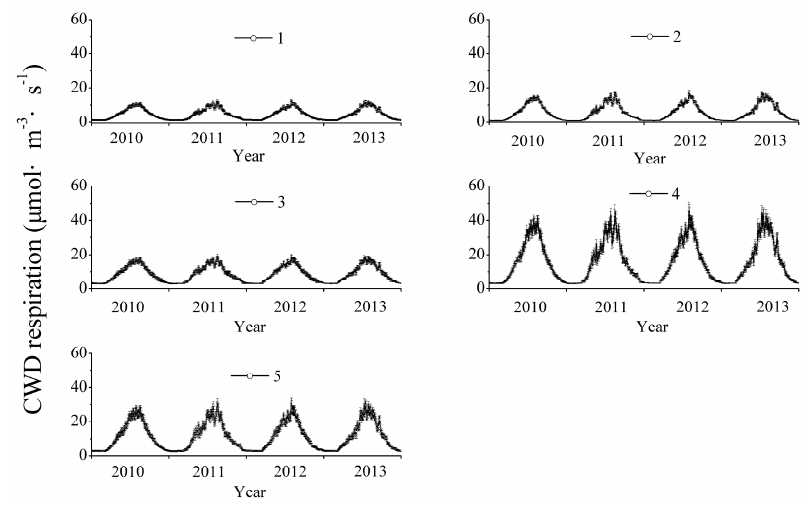
Figure 2. The daily mean respiration of different coarse woody debris (CWD) decay classes in the L. principis-rupprechtii forest during 2010–2013. Error bars are based on 0.5 h soil temperatures as experimental unit ( n = 48). experimental unit ( n = 48).